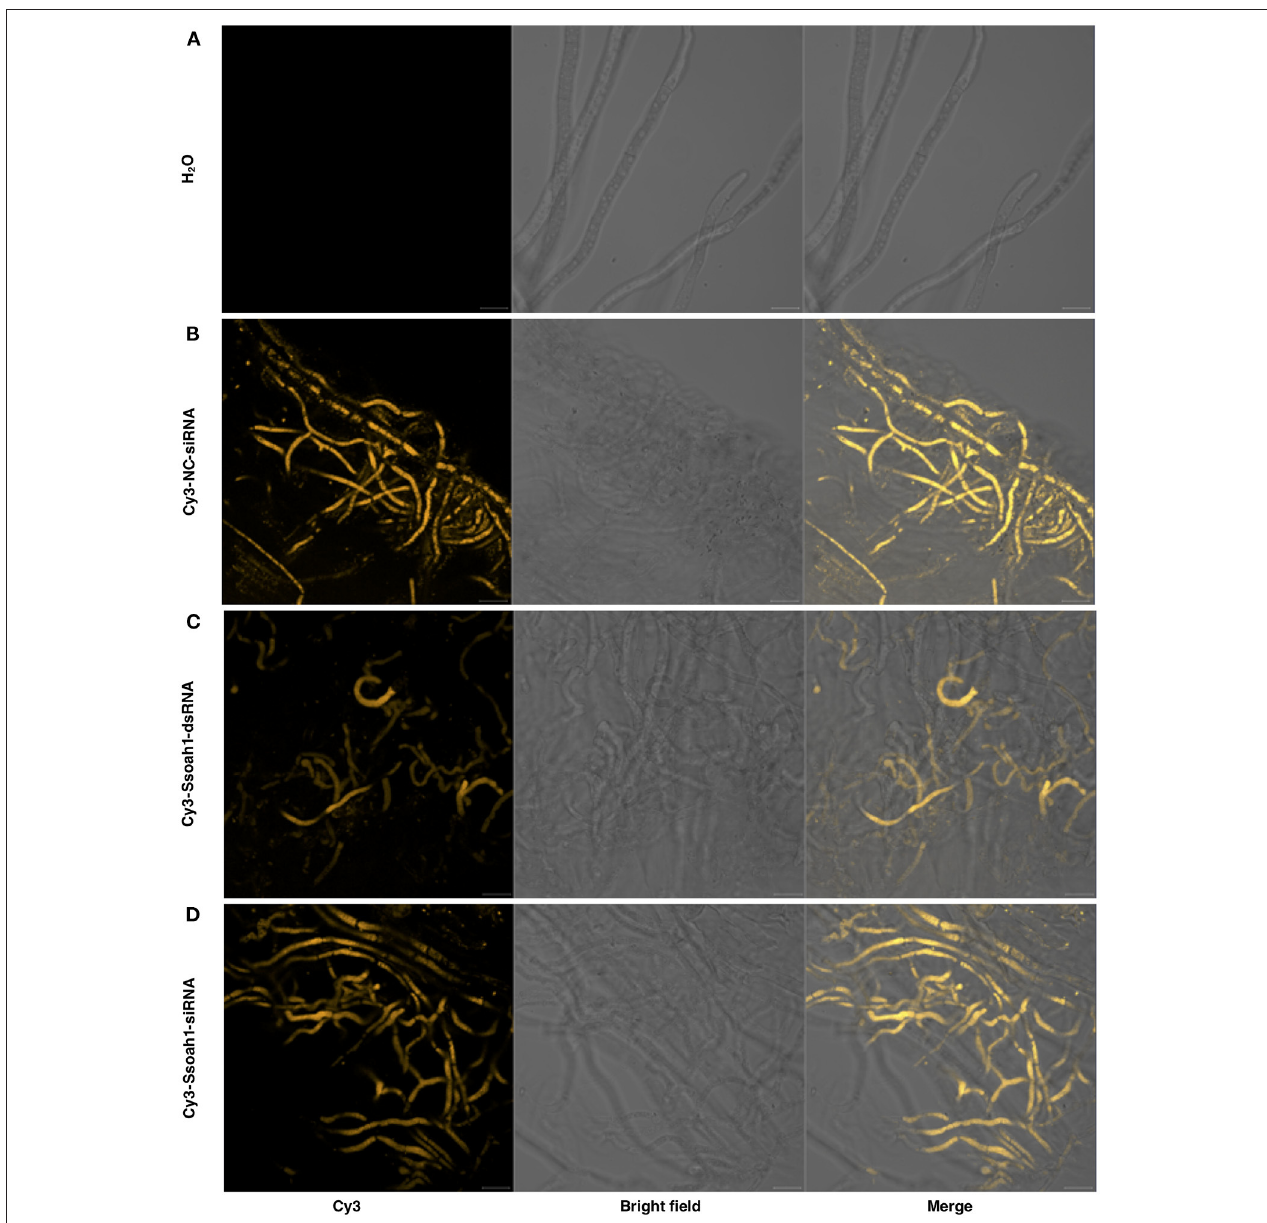
FIGURE 1 | External RNAs are taken up by Sclerotinia sclerotiorum . Treatments were added to potato dextrose broth (PDB) containing 2 day old S. sclerotiorum mycelia originally grown on potato dextrose agar (PDA). Fluorescent signals were detected using confocal fluorescent microscopy. (A) An application of water, as a negative control, yielded no signal. (B) The positive control, application of Cy3-labeled-nocoding siRNA (Cy3-NC-siRNA, with no specific targets in S. sclerotiorum) , (C) 4 µ g application Cy3-labeled- Ssoah1 -dsRNA, and (D) application of 4 µ g of Cy3-labeled- Ssoah1 -siRNA (targeting Ssoah1 in S. sclerotiorum ) produced fluorescent signals that were detected 13h post inoculation. Scale bars = 20 µ